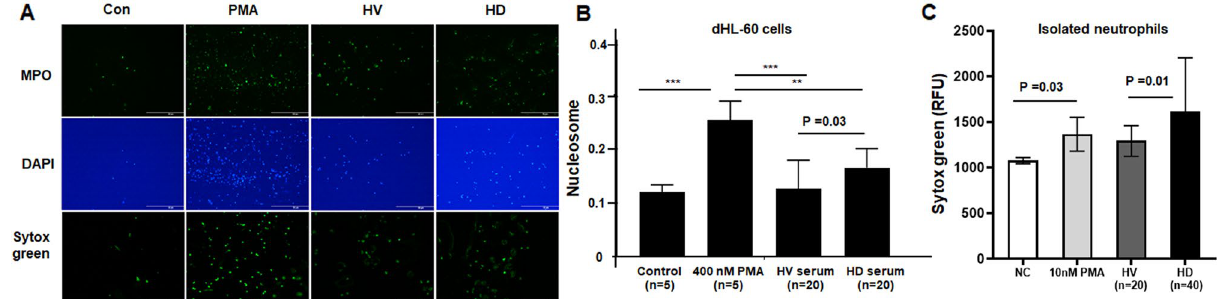
Figure 4. Induction of NETs by dHL60 cells. ( A ) Detection of NETs by immunofluorescence. HL60 cells were differentiated for 6 days and treated with 0 or 400 nM PMA, HV serum, or HD serum for 17 h. NETs were visualized by co-staining with myeloperoxidase (MPO) and DAPI, or by staining with Sytox Green (magnification, ×100). ( B ) Quantification of cell-free nucleosomes with dHL-60. HL-60 cells were differentiated for 6 days and treated with 0, 400 nM PMA, HV serum, or HD serum for 17 h. DNA released from the nucleus was digested by nuclease. More nucleosomes were released in HD serum than in HV serum. ( C ) The release of NETs from fresh isolated neutrophils. Similar to the results with dHL-60 cells, uremic serum induced significantly increased NETs compared to control serum. Results are means ± SEM, Student’s t -test.